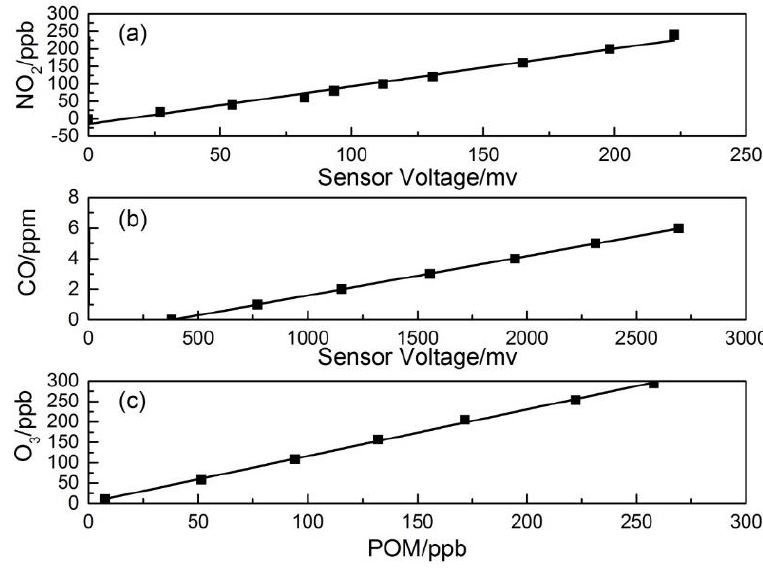
Figure 4. Linearity test results in dry gas conditions of ( a ) the NO 2 sensor; ( b ) the CO sensor; ( c ) POM. Table 2. Laboratory test results of NO 2 and CO sensors and POM on dry gas. Sensor Equation R 2 Lower Detection Limit NO 2 -B4 (NO 2 ) Y = 1.08X − 15.14 0.99 6 ppb CO-B4 (CO) Y = 0.0026X − 0.99 0.99 0.02 ppm POM (O 3 ) Y = 1.14X + 2.06 0.99 4 ppb